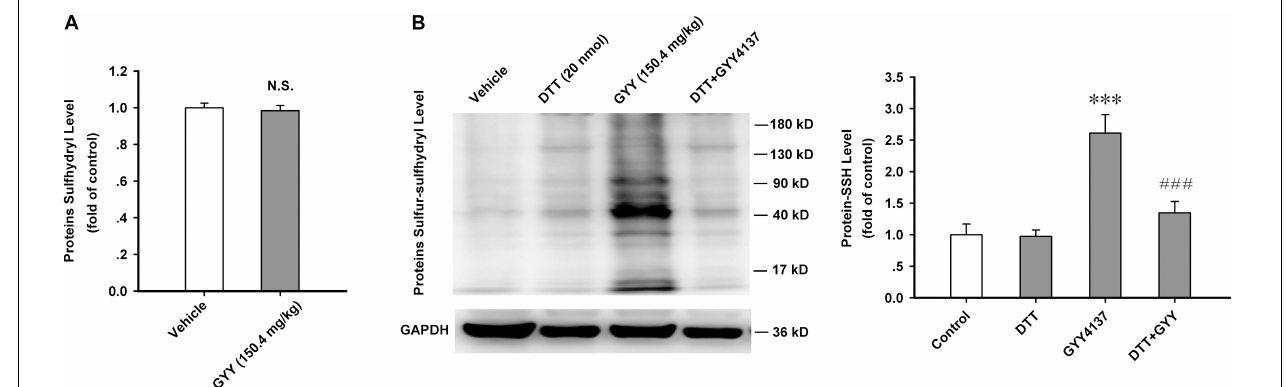
FIGURE 4 | GYY4137 increases the protein sulfur-sulfhydrylation level in ARC tissue. (A) GYY4137 (150.4 mg/kg) did not influence the total protein sulfhydryl level in ARC tissue of mice ( n = 10). N.S., no statistical difference. (B) GYY4137 (150.4 mg/kg) increased the protein sulfur-sulfhydryl level in ARC tissue and this effect was blocked by DTT (20 nmol for each mouse; n = 5). Protein-SSH, protein sulfur-sulfhydryl. Data are normalized as folds to control and expressed as means ± SEM. One-way ANOVA and post hoc tests were used. ∗∗∗ P < 0.001 vs vehicle; ### P < 0.001 vs GYY.